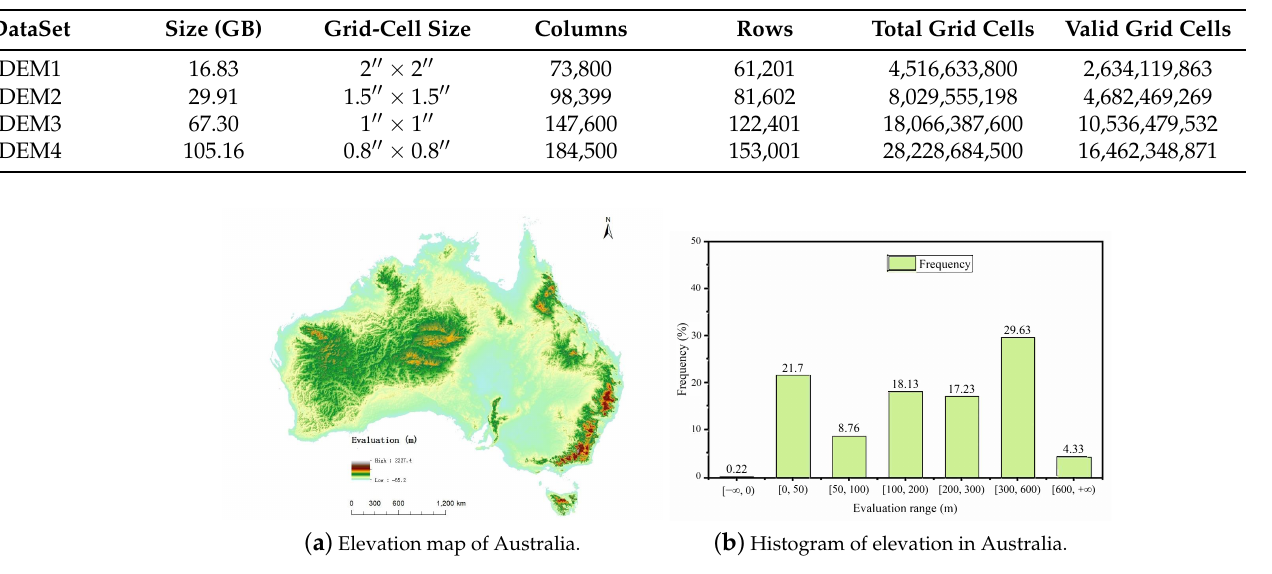
Figure 9. Elevation map and histogram of